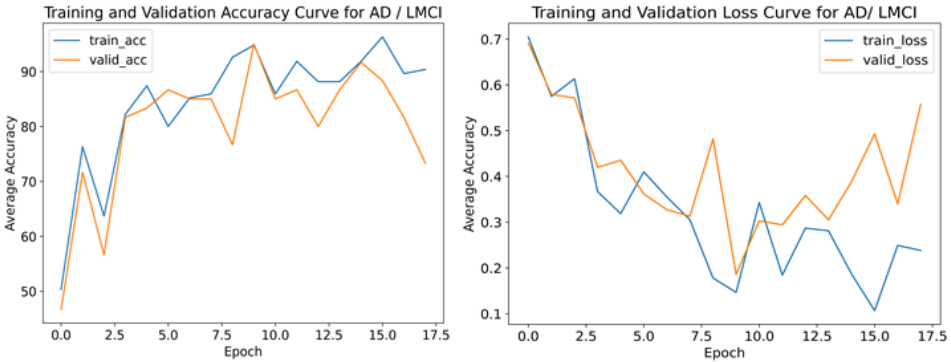
Figure 4. Training accuracy, validation accuracy, training loss, and validation loss for the proposed ViT model for AD/LMCI classification.